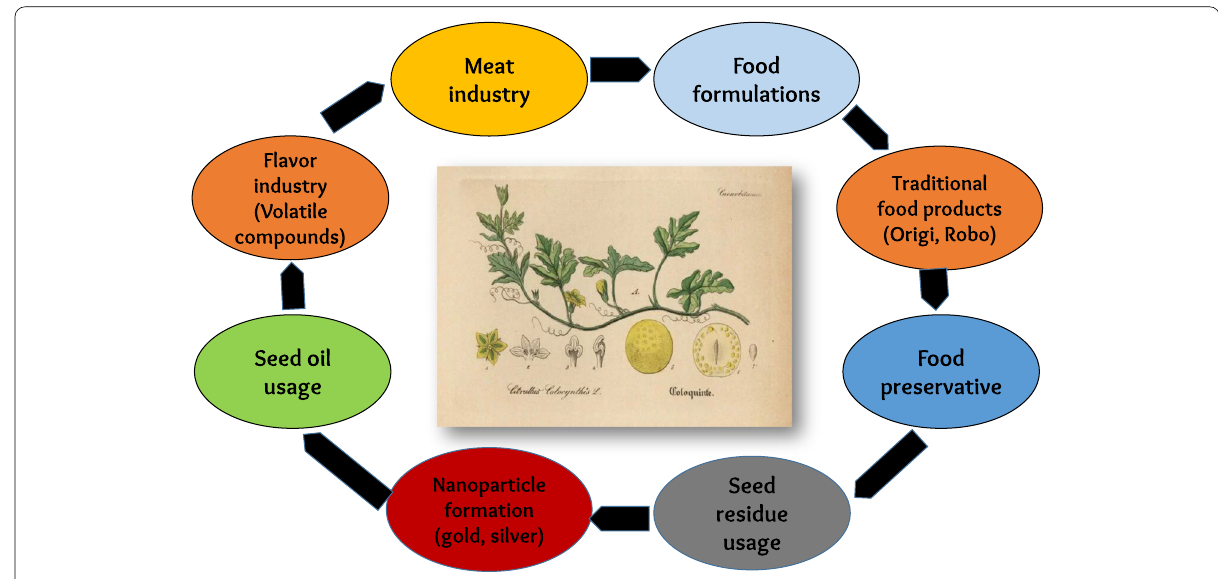
Fig. 1 Application of Bitter Apple ( Citrullus colocynthis ) in food